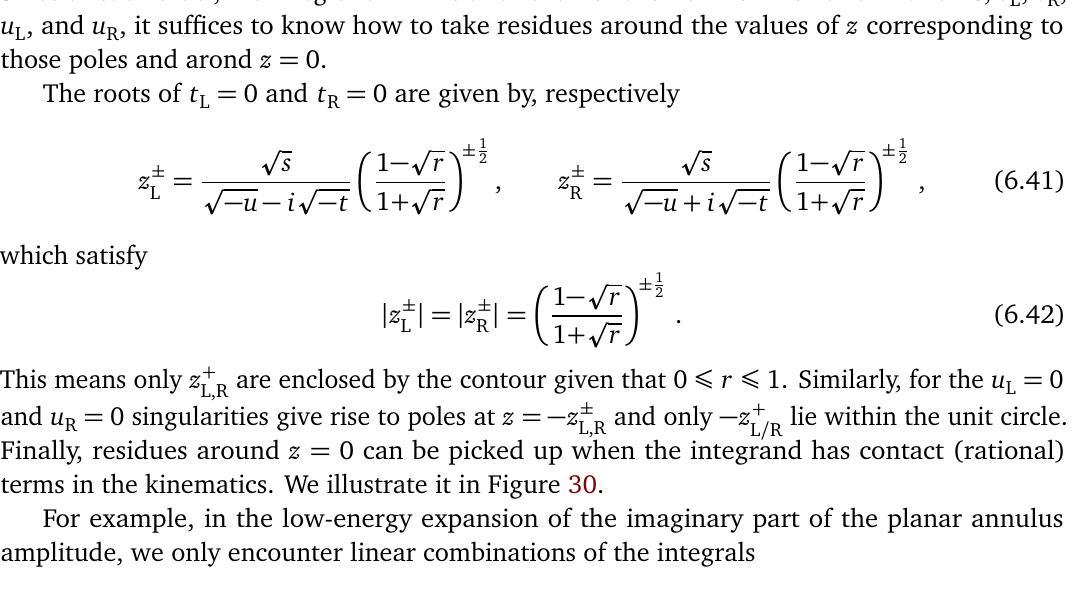
Figure 30: The five singularities contributing to the evaluation of the phase-space integral at z = ( z + , z + , − z + , − z + ,0 ) , responsible respectively for: massless t L R L R u -, and u -channel exchanges, as well as the contact terms. The red contour is at L R | z | = 1. If the A L / R had massive poles or branch cuts, they would similarly show up 0 within the unit